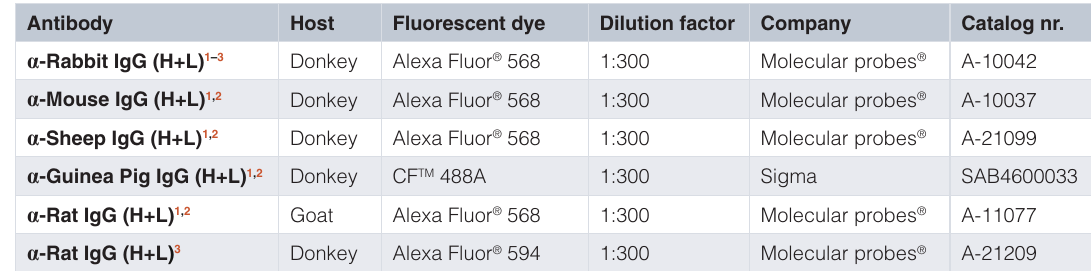
Table 3. Secondary antibodies used for immunostaining of 1 hippocampal sections, 2 hippocampal neurons and 3 spinal cord sections. Antibody